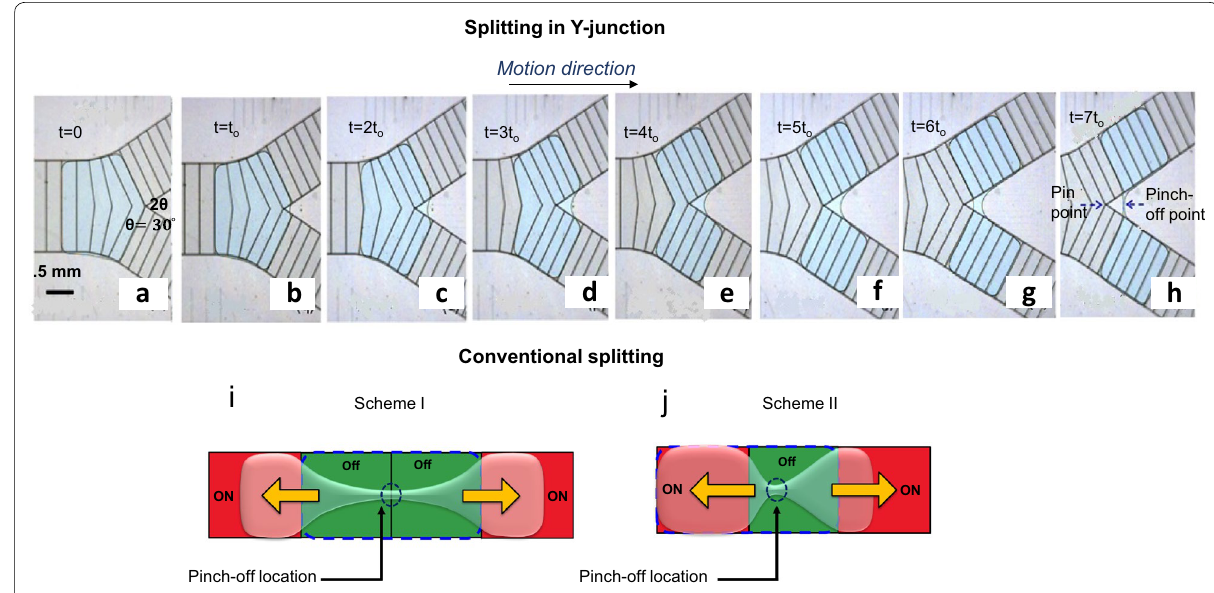
Fig. 4 a – h Steps of the process of splitting a droplet by Y-junction with switching time (t0). The location of pinch-off occurs on the right from the pin-point. 2θ is the angle between two branches of Y-junction. i – j Droplet splitting in conventional device with scheme I and II respectively. The yellow arrows show fluid motion during splitting. Blue dashed line is the initial droplet